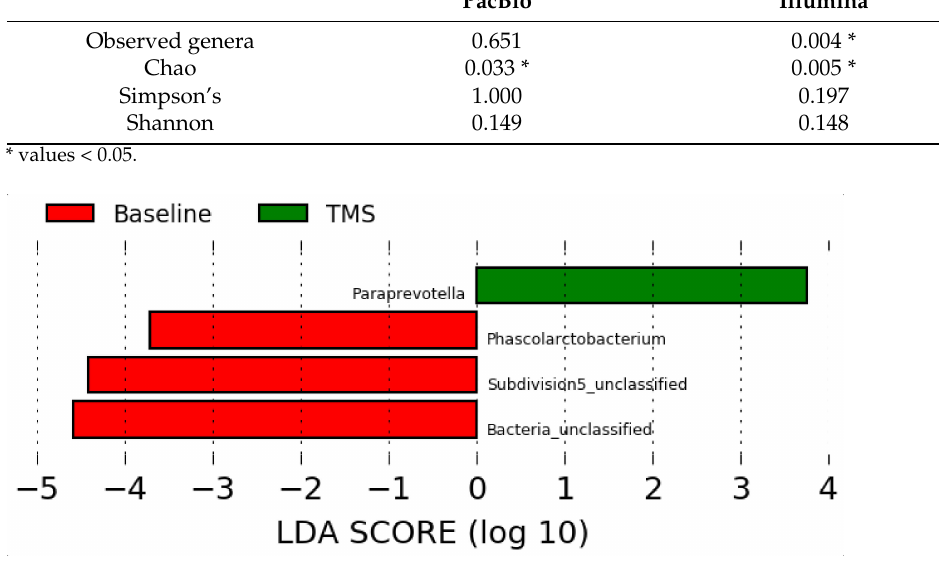
Figure 4. Linear discriminant analysis effect size (LEfSe) using data at the genus level obtained by short reads sequencing before (“Baseline”) and after (“TMS”) TMS